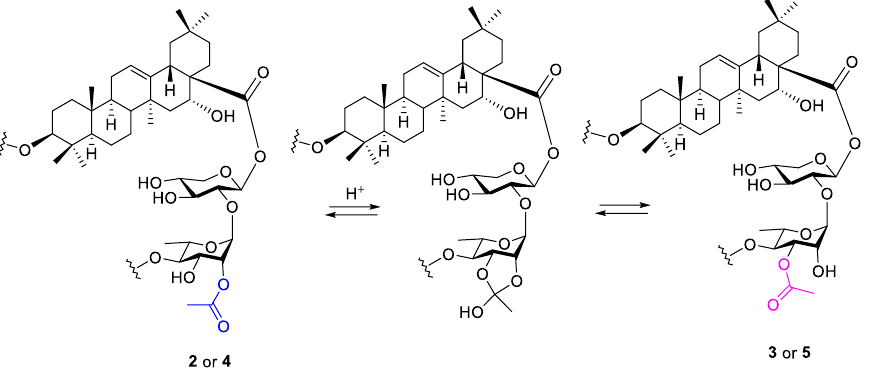
Figure 3. Possible mechanism of acetyl group transfer from 2 or 4 to 3 or 5 in [26].